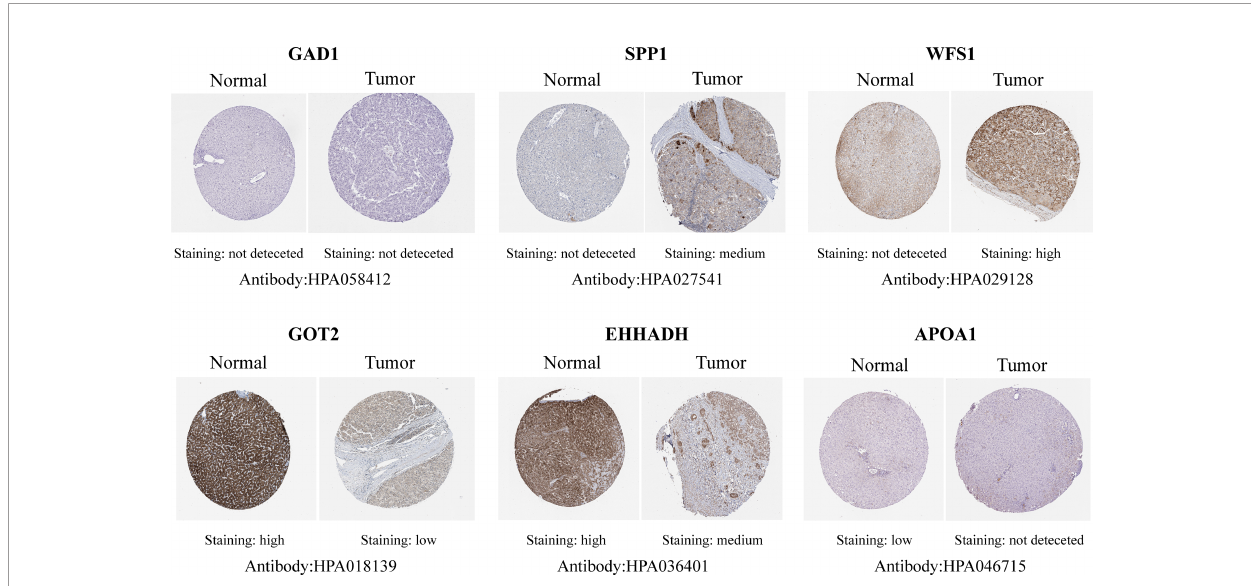
FIGURE 5 | Representative immunohistochemistry staining validation of the expression of six MRGs. Protein expression levels of GAD1, SPP1, WFS1, GOT2, EHHADH, and APOA1 in HCC tissues were obtained from the Human Protein